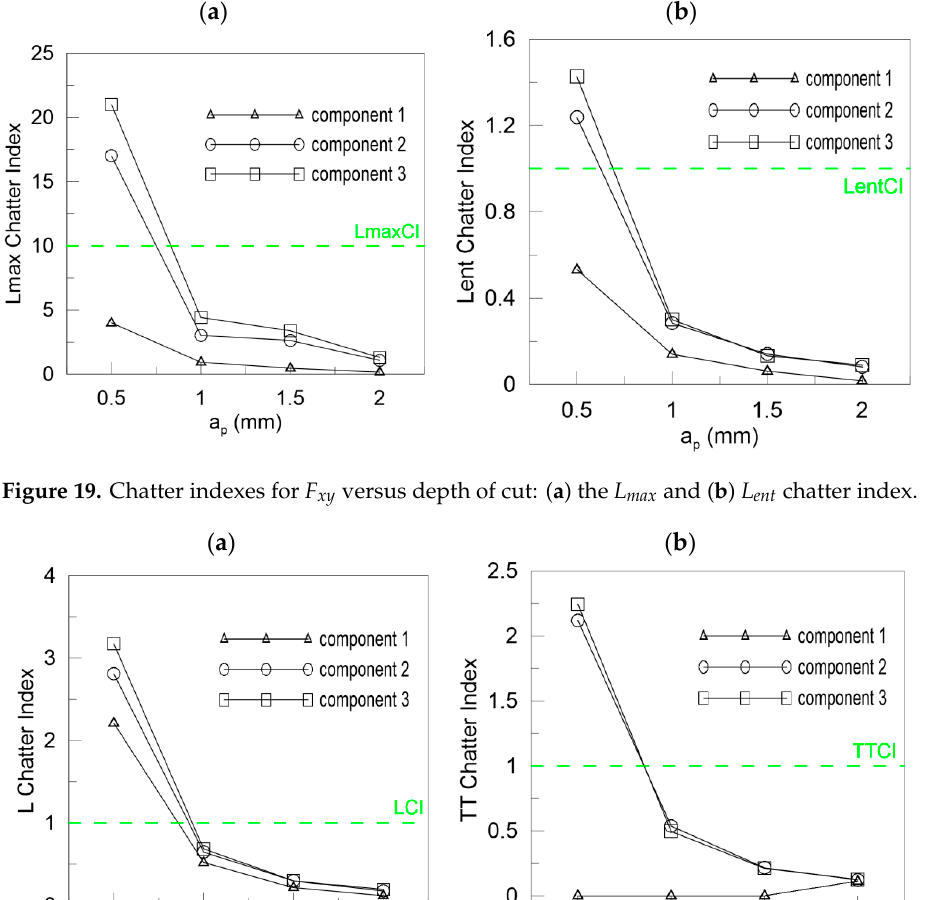
Figure 18. Chatter indexes for F xy versus depth of cut: ( a ) the largest Lyapunov exponent and ( b ) the Lyapunov chatter index.